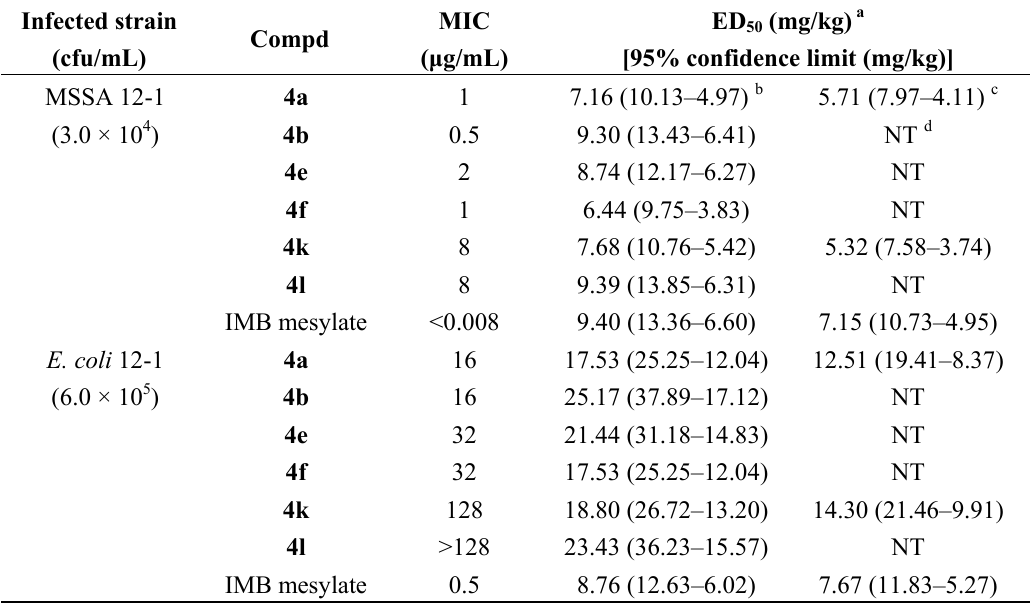
Table 3. In vivo efficacy of selected compounds against systemic infections in